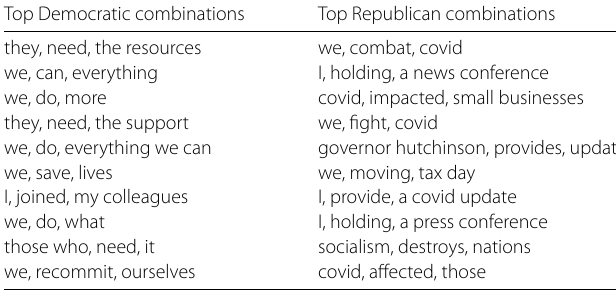
Table 4 Top Agent, verb, and Patient combinations in Democratic and Republican tweets extracted by semantic role labeling with largest differences in frequency. The left column shows the combinations where the frequencies in Democratic tweets are larger than the frequencies in Republican tweets, and vice versa. Most combinations in Democratic tweets focus on resources and support, while combinations in Republican tweets discuss combating COVID, news updates, support for small businesses, and the threat of socialism Top Democratic combinations Top Republican